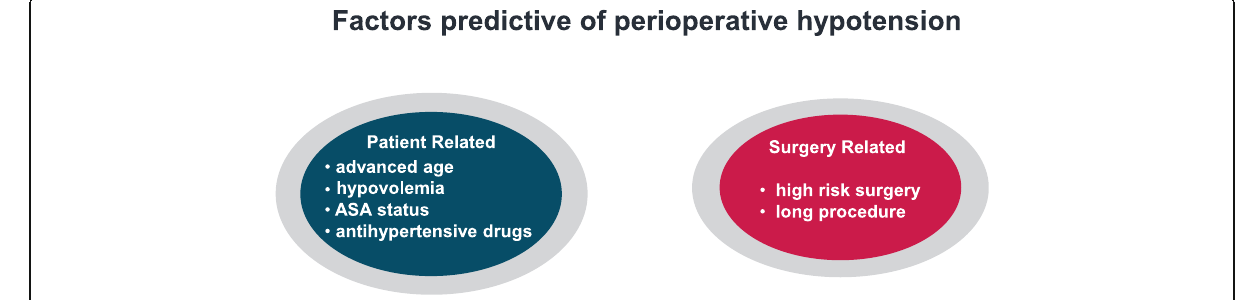
Fig. 2 Predicting factors of perioperative